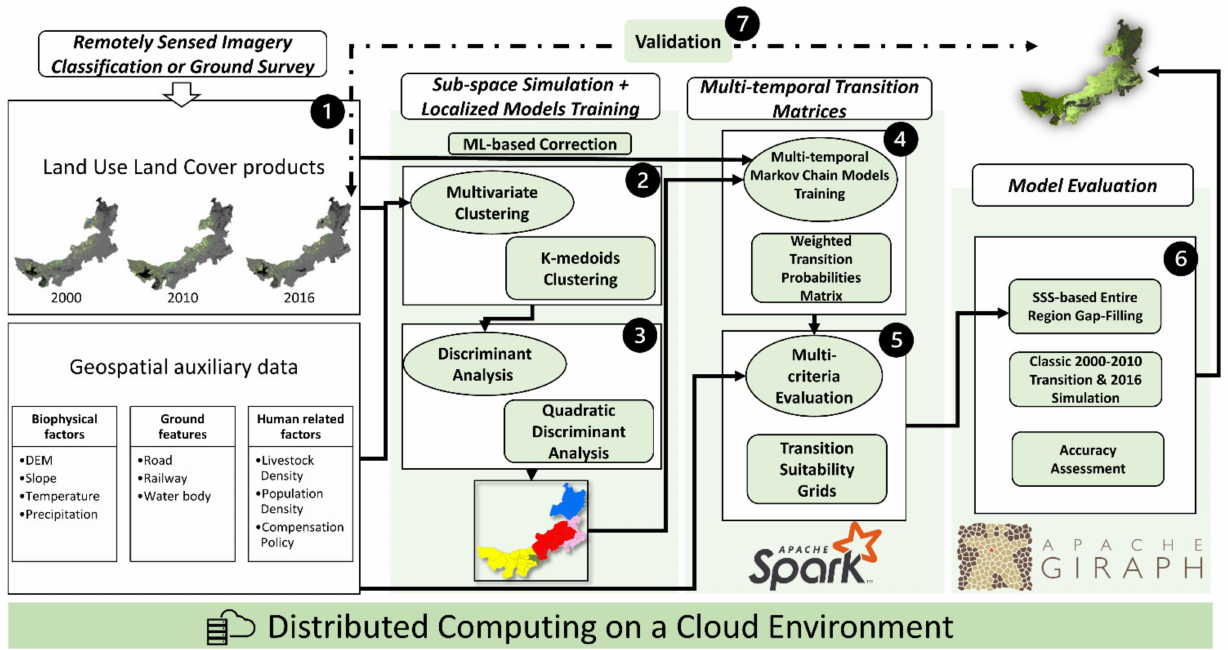
Figure 2. Workflow for the cloud-based LULC gap filling process (Numbers 1, 2, 3, 4, 5, 6, and 7 correspond to the seven steps in the following